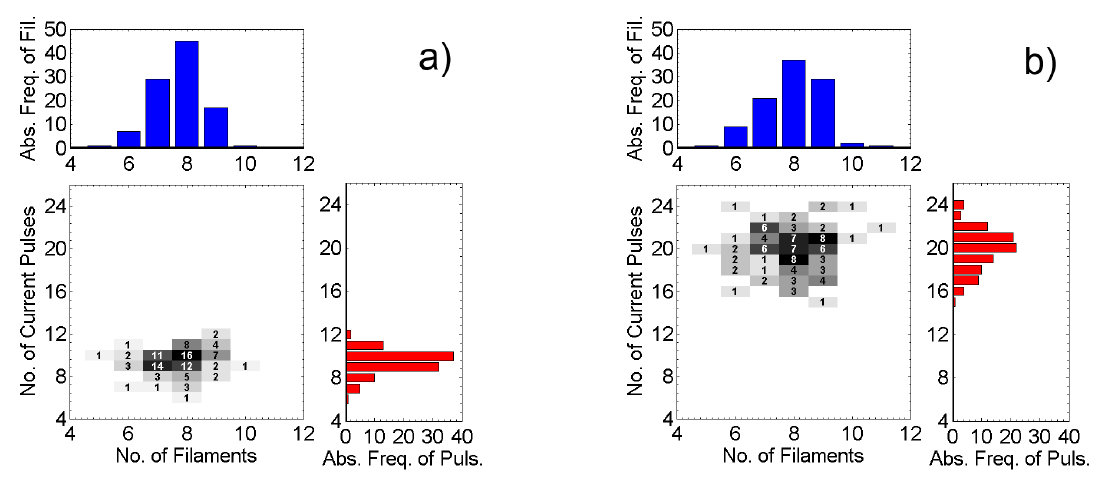
Figure 11 : Relation matrix of incidence, DCSBD at voltage amplitude 16 kV and electrode gap 2.0 mm; a) positive half-period, b) whole period of